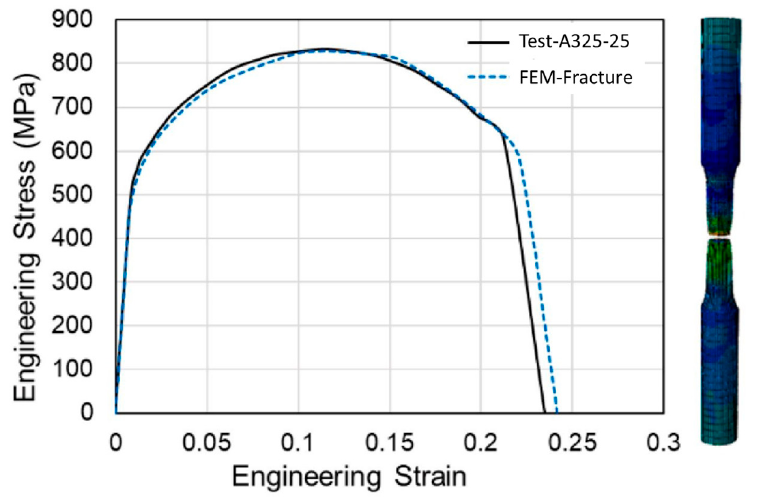
Figure 10. Stress–strain curve of A325 bolts obtained by experimental tests and FEM modelling [91].